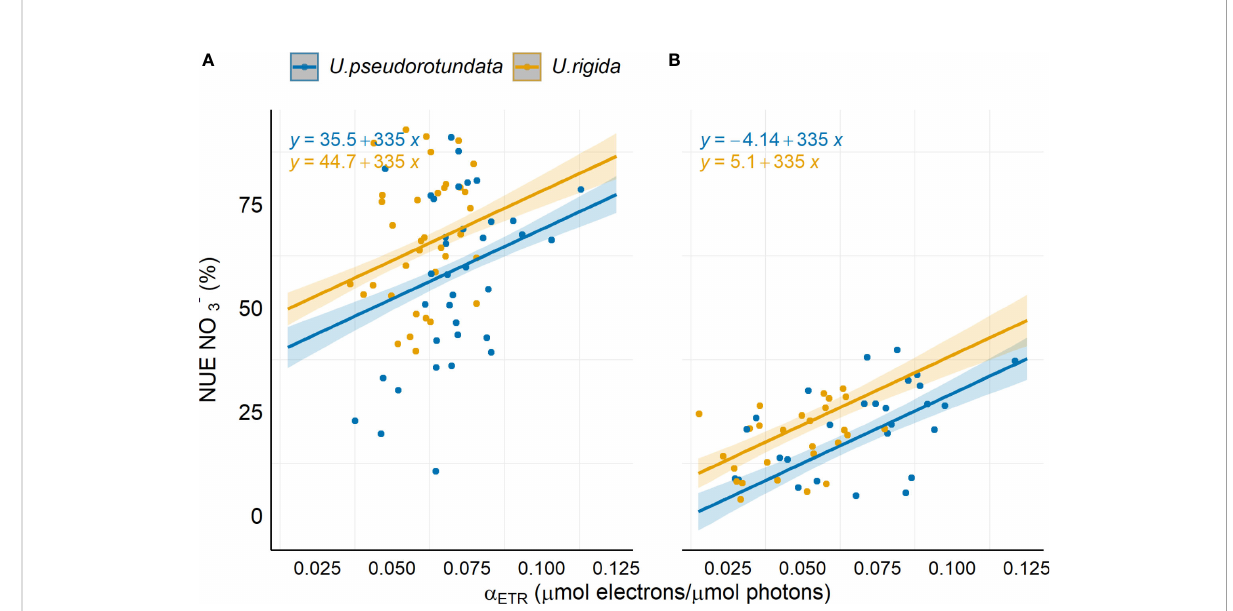
FIGURE 7 Linear regression model between NO 3 - uptake ef fi ciency (NUE) and photosynthetic ef fi ciency ( a ETR ) for the species U. pseudorotundata and U. rigida grown in (A) 50% fi sh farm ef fl uent and (B) 100% fi sh farm ef fl uent. The solid line represents the fi tted values of the overall model.